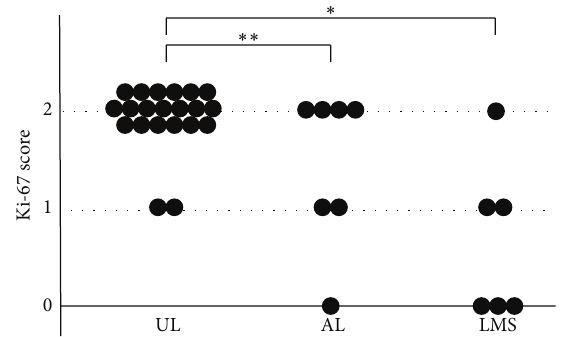
Figure 4: IHC score in SMTs. A significant difference was found in the LMP2 score for UL and AL, for UL and LMS, and for AL and LMS ( ∗ 𝑃 < 0.01 ).